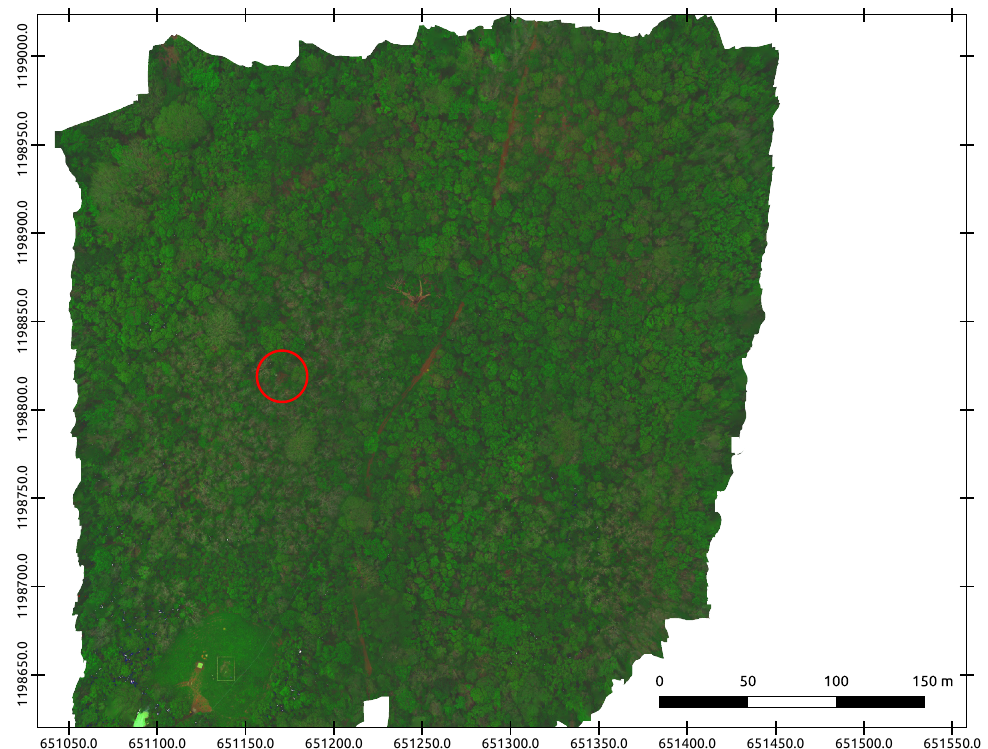
Figure 3. True-color (RGB) VIS-NIR orthomosaic of the Micasense RedEdge camera providing an overview of the whole flight area. The red circle indicates the position of the EC